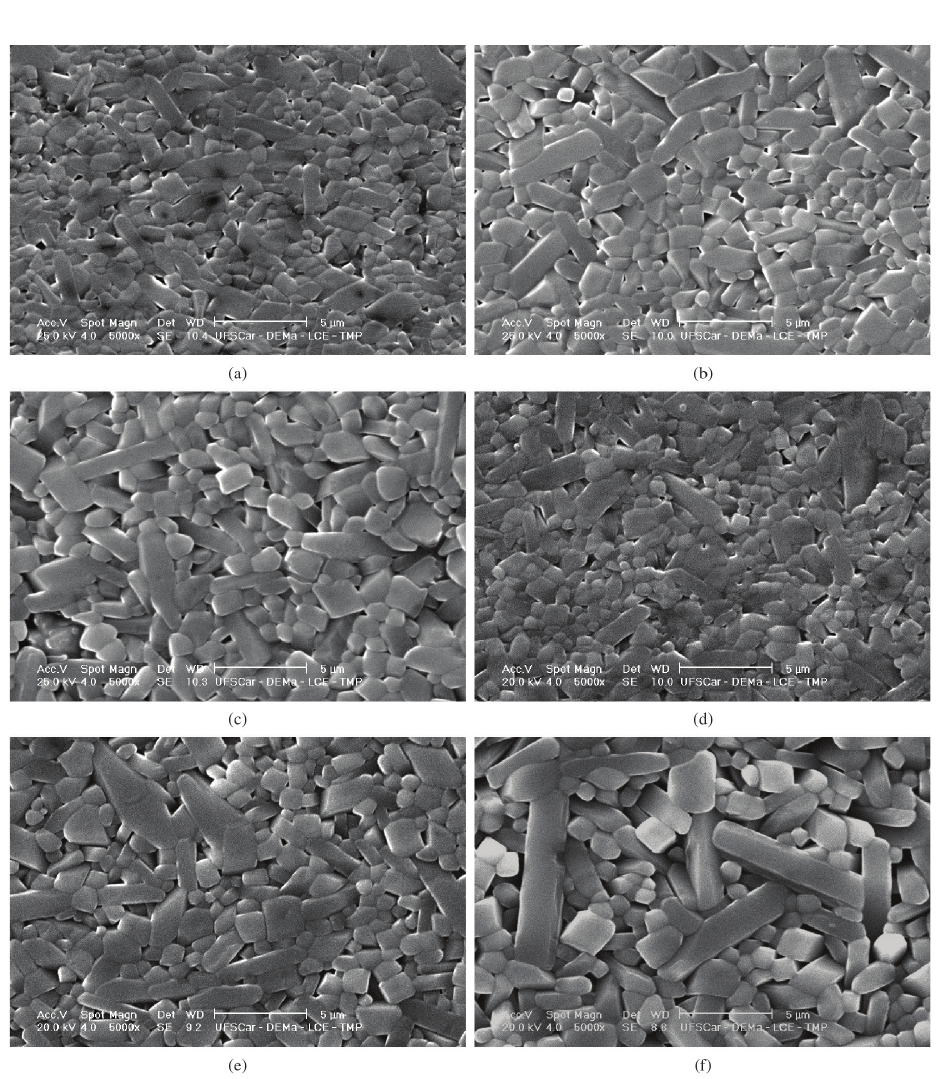
Figure 12. SEM micrographs of MgO doped samples microwave-sintered at: 1.8kW/30min (a) 0.5M, (b) 1M, (c) 2M; and 1.8kW/40min (d) 0.5M, (e) 1M, (f)